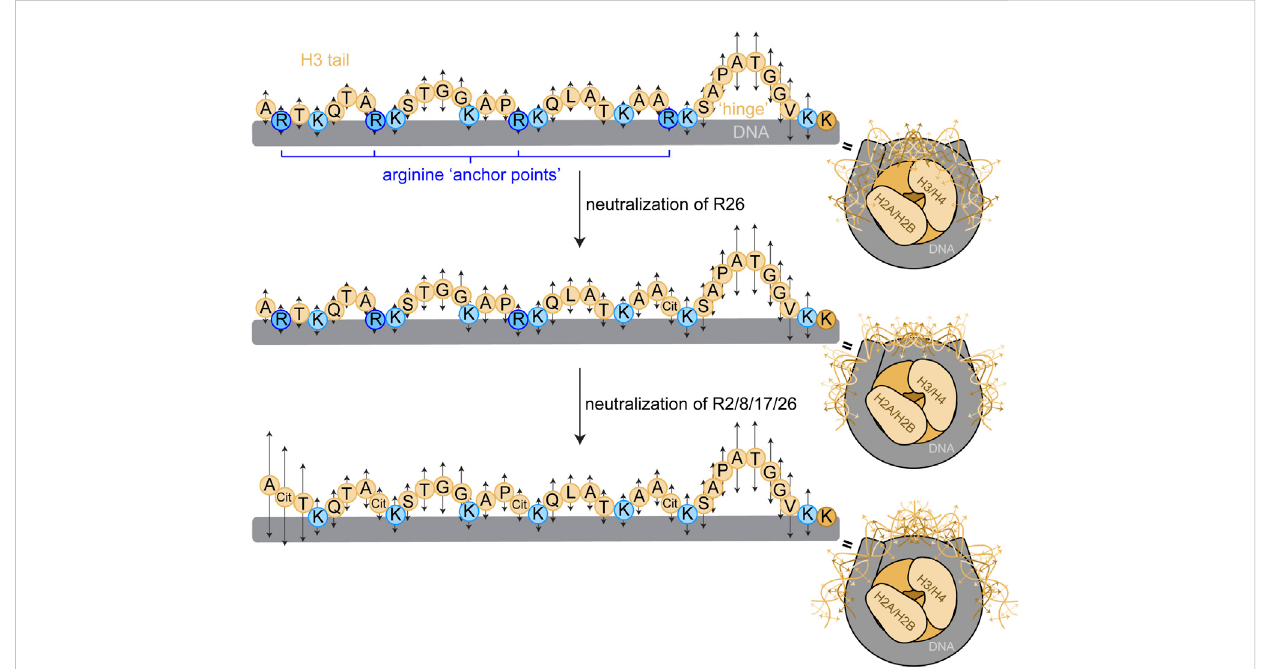
FIGURE 6 Proposed model for arginine ‘ anchorpoints ’ inH3 tail dynamics.We propose amodel wherein H3 tail residues existin adynamicensemble ofDNA- bound conformations, and each residue has a microscopic site-binding constant for DNA that dictates the local, fast-timescale (ps-ns) dynamics of the residue (representedby arrows). Basic residueshave stronger site-binding constants and thus slower motions (shorter arrows). Uncharged residueshave aweakersite-bindingconstantandthusfastermotions(longerarrows),andlongerstretchesofunchargedresiduesbuilduptofasterdynamicsasin the TGG repeats and the putative ‘ hinge ’ region. Mutating arginine anchor points increases the regional mobility around the arginine position by weakening the microscopic site-binding constant for DNA. These ps-ns timescale motions build up to slower timescale motions that involve global tail conformational rearrangements, illustrated by the conformational ensemble (only a few discrete states of a broad ensemble depicted) of the H3 tails within the NCP (right). Sequential neutralization of charges would have a profound effect on tail accessibility. A cartoon depiction of the NCP shows a complexoftwoH3/H4dimersandtwoH2A/H2Bdimers(shadesofbeige)wrappedbyDNA(grey)asinFigure1.TheH3tailsequenceisexplicitlydepicted withcirclesrepresentingresidues.Thebulkofthetailisrepresentedinlightbeigewithbasicresidueshighlightedinblue,arginineindarkblueandlysinein light